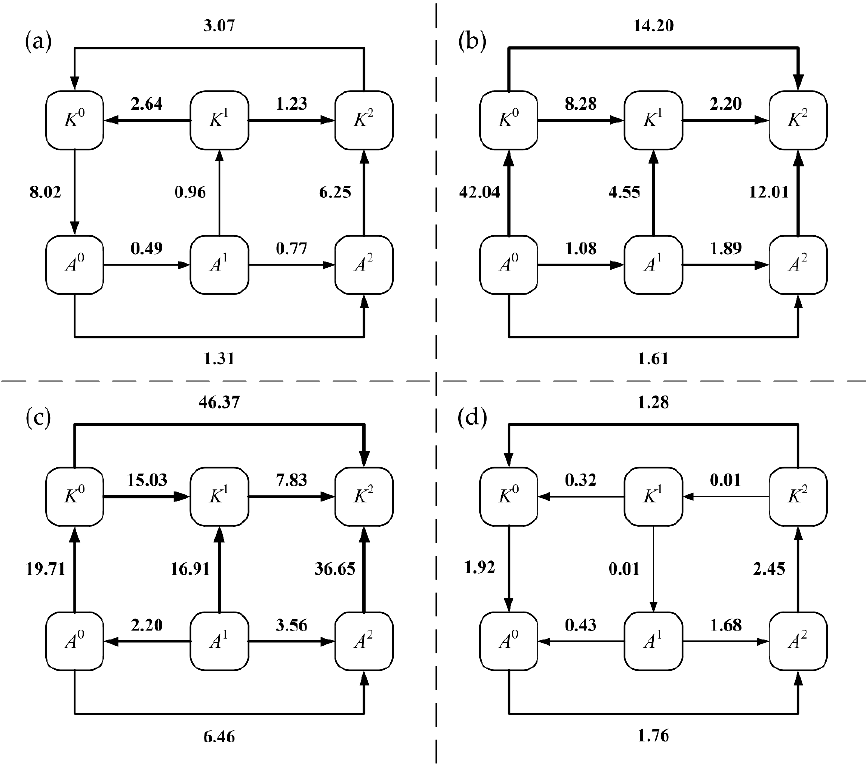
Figure 14. The energy diagram (refers to Figure 2; volume-averaged) for the four subregions in Figure 1. The units are in 10 − 6 Wm − 3 . ( a ) LUZ; ( b ) LS; ( c ) WPO; ( d ) SCS.